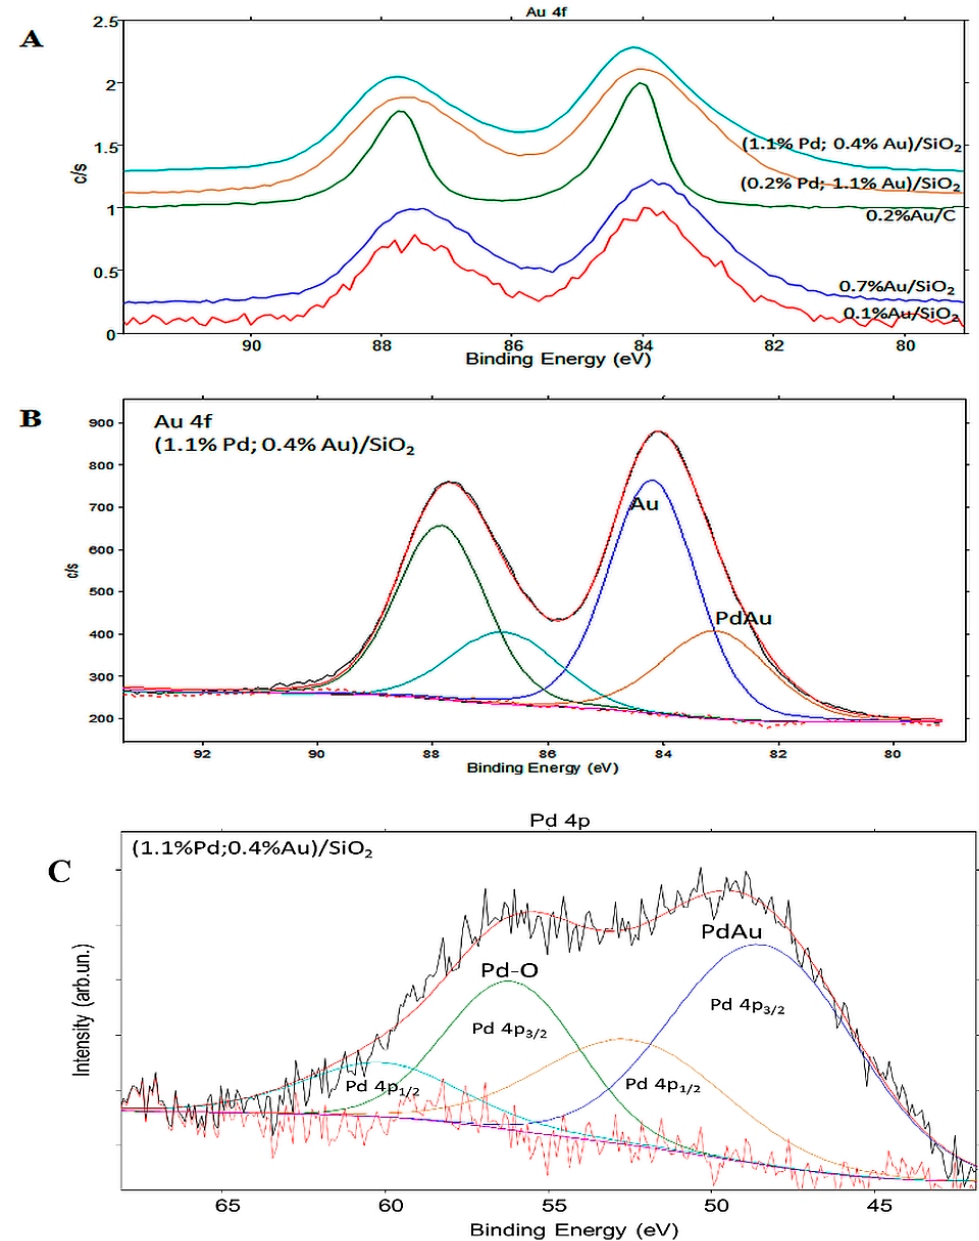
Figure 3. XPS results of the Au nanoparticles (NPs), ( A ) set of Au 4f spectra for the 0.1% Au/SiO 2 , 0.7% Au/SiO 2 , Au/C, (1.1% Pd; 0.4% Au)/SiO 2 and (0.2% Pd; 1.1% Au)/SiO 2 samples, ( B ) XPS spectrum and the result of fitting the Au 4f spectrum for the (1.1% Pd; 0.4% Au)/SiO 2 sample showing the two chemical states of the Au ( C ) Pd 4p spectrum with the result of fitting and suggested Pd chemical states for (1.1% Pd; 0.4% Au)/SiO 2 .